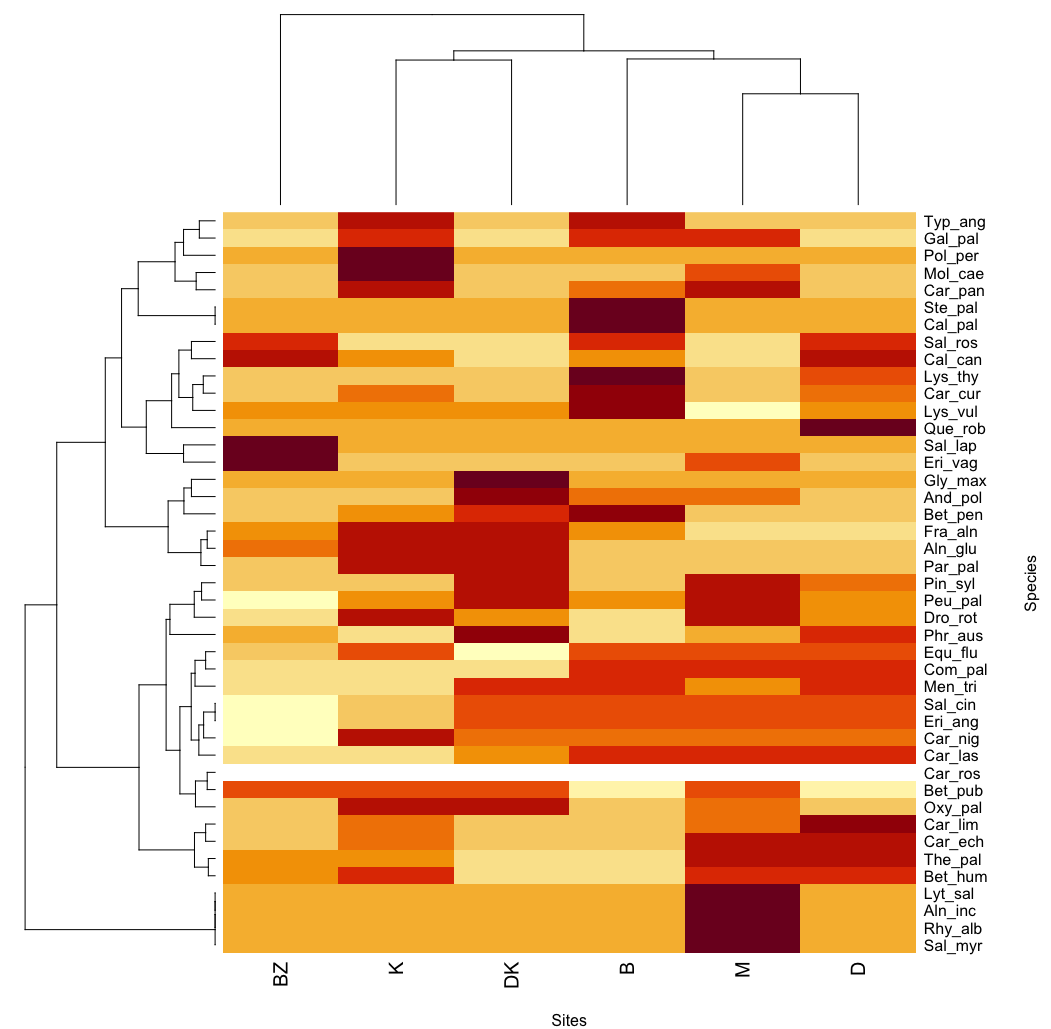
Figure 6. Dendrogram and heatmap of hierarchical agglomerative cluster analysis, based on Jaccard’s coefficient and the Ward method, of 43 species and the study sites Lake Bikcze (B), Lake Karaśne (K), Lake Długie (D), Lake Moszne (M), the mid-forest bog Blizionki (BZ) and the Dekowina (DK)